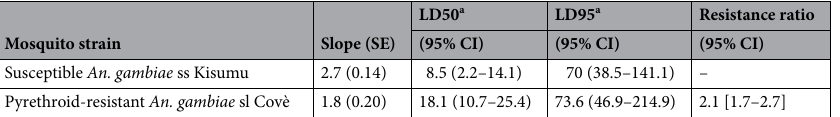
Table 1. Lethal dose of broflanilide on pyrethroid-resistant An. gambiae sl Covè exposed in CDC bottle bioassays. a Lethal doses are expressed in µg/ml.